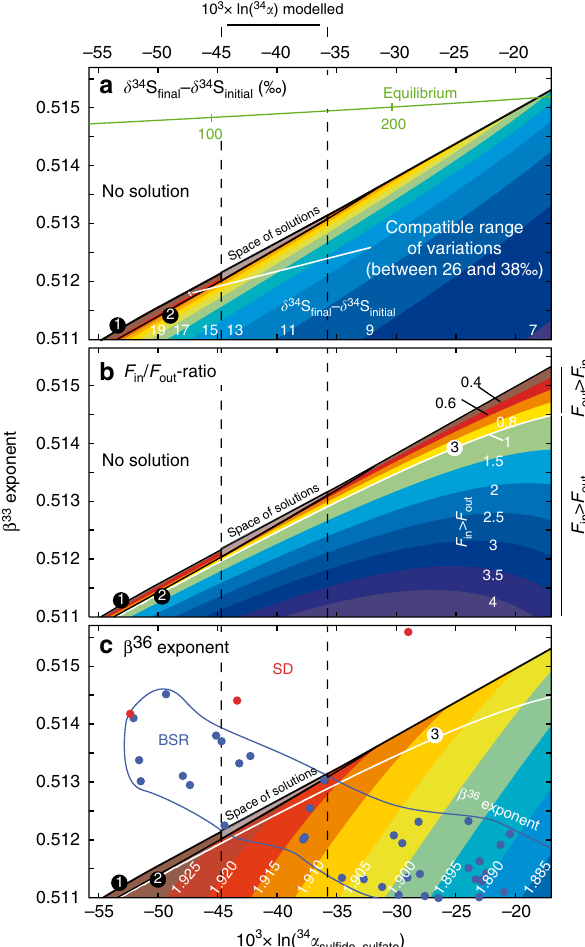
Figure 3 | Model results in three 1,000ln( 34 a ) versus 33 b (cid:3) exponents diagrams. The results show the combinations of 33 b , 34 a and F in / F out that fit our data in 1,000ln( 34 a ) versus 33 b (cid:3) exponents diagrams. ( a ) illustrates the d 34 S CAS -range (that is, d 34 S CASfinal (cid:3) d 34 S CASinitial ) compatible with our data. The curve #2 delimitates the field below which the difference between d 34 S CASfinal and d 34 S CASinitial values ( þ 38 % and þ 12 % , respectively) is too low (that is, d 34 S CASfinal (cid:3) d 34 S CASinitial o 26 % ) to account for the high d 34 S CAS -values measured in our section. ( b ) illustrates the F in / F out -ratios that fit the observed d 34 S CAS versus D 33 S CAS slope for each pair of 33 b , 34 a . The white curve #3 highlights the steady-state conditions, where F in ¼ F out . ( c ) represents the combinations of 33 b and 34 a compatible with our data for different 36 b values. The intercept between the modelled space of solution and results from BSR experiments allows restricting further the space of solution. The grey polygon represents the final solution